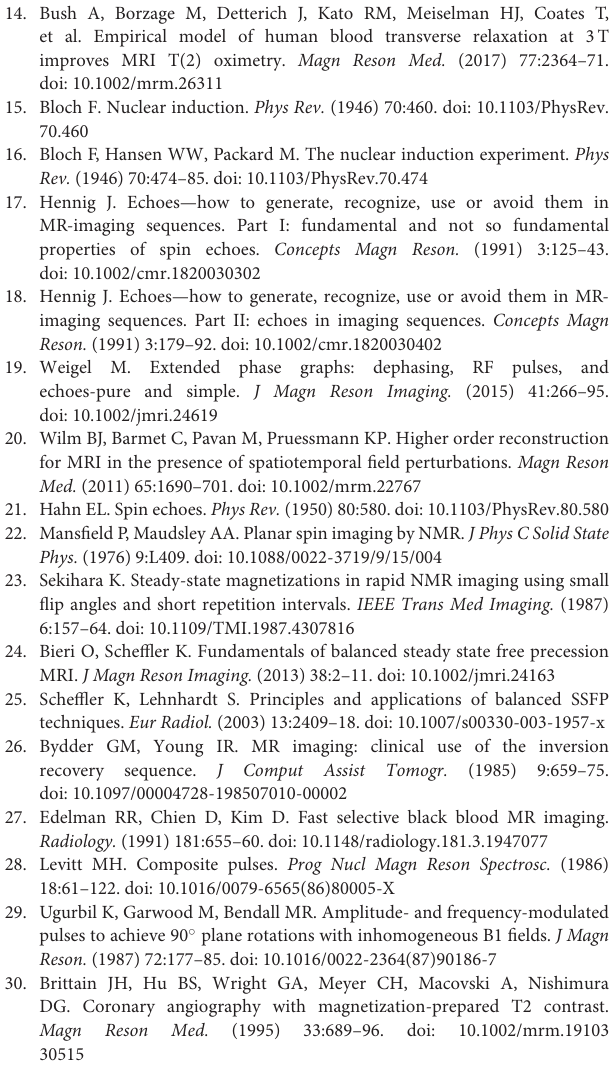
Supplementary Figure 2 | Balanced steady-state free precession cine demonstrating a jet of aortic regurgitation (arrow). This cannot be reliably quantified by visual assessment of the jet and once detected should be further evaluated using phase-contrast velocity mapping. Supplementary Figure 3 | Quantification of aortic regurgitation in the patient depicted in Figure 9 using phase-contrast velocity mapping. The magnitude image on the top right is used to contour a region of interest in the aorta. The phase image on the top left is used to determine flow and plot this against time (bottom). The flow drops below the baseline for the whole of systole. The regurgitant volume is ∼ 67ml which amounts to a regurgitant fraction of 60%, denoting severe regurgitation. Supplementary Figure 4 | An example of a clinical imaging protocol library built with three acquisition strategies for managing irregular rhythms: Sinus Rhythm; Mildly Irregular Rhythm; Severely Irregular Rhythm. Supplementary Table 1 | A general cardiomyopathy protocol can be modified to assess acute presentations by the addition of imaging sequences sensitive to oedema